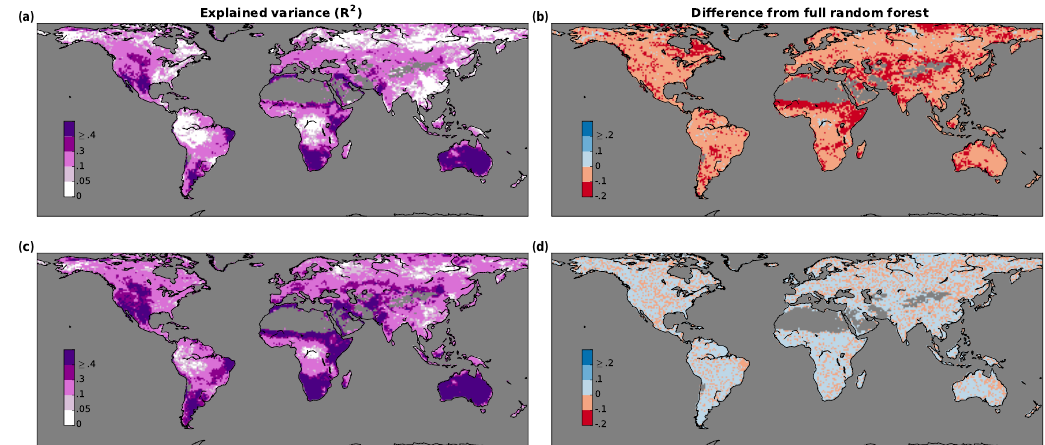
Figure 7. Analysis of spatiotemporal aspects of our framework. (a) Explained variance ( R 2 ) of NDVI anomalies based on a full random forest model in which all climatic variables are included as predictors as in Fig. 5a, except for the cumulative variables and the extreme indices (see Sect. 3.3). (b) Difference in terms of R 2 between the model without cumulative and extreme predictors and the full random forest model in Fig. 5a. (c) Explained variance ( R 2 ) of NDVI anomalies based on a full random forest model in which all climatic variables are included as predictors as in Fig. 5a, as well as the predictors from the eight nearest neighbours. (d) Difference in terms of R 2 between this full random forest model which includes spatial information from neighbouring pixels and the full random forest model in Fig. 5a.